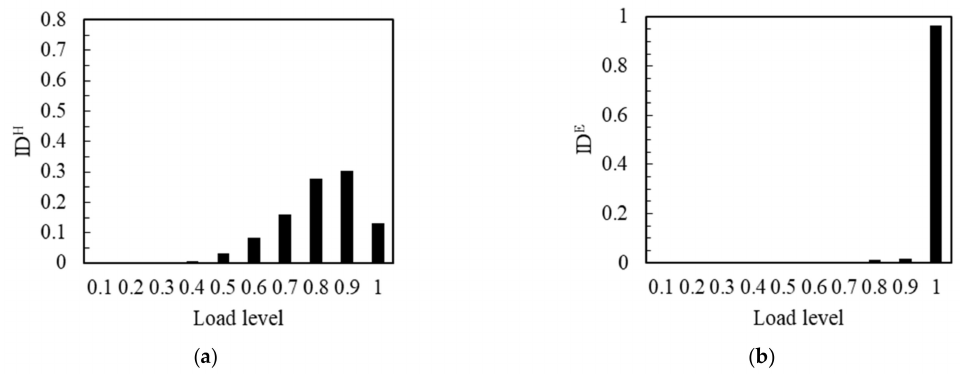
Figure 8. ID H and ID E of the No.11 notched beam: ( a ) ID H ; ( b ) ID E